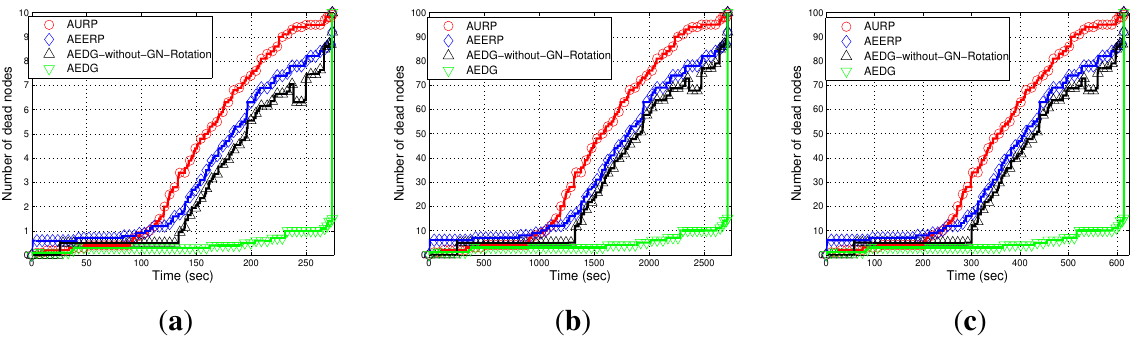
Figure 10. Number of dead nodes. ( a ) 10 nodes deployed in 100 m × 100 m; ( b ) 100 nodes deployed in 100 m × 100 m; ( c ) 100 nodes deployed in 10 km × 10